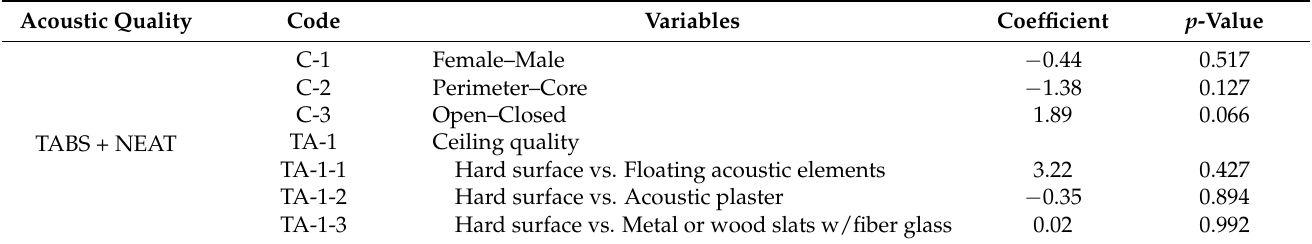
Table 10. Correlation analysis between TABS, Noise Criteria, and COPE satisfaction with background noise ( n =